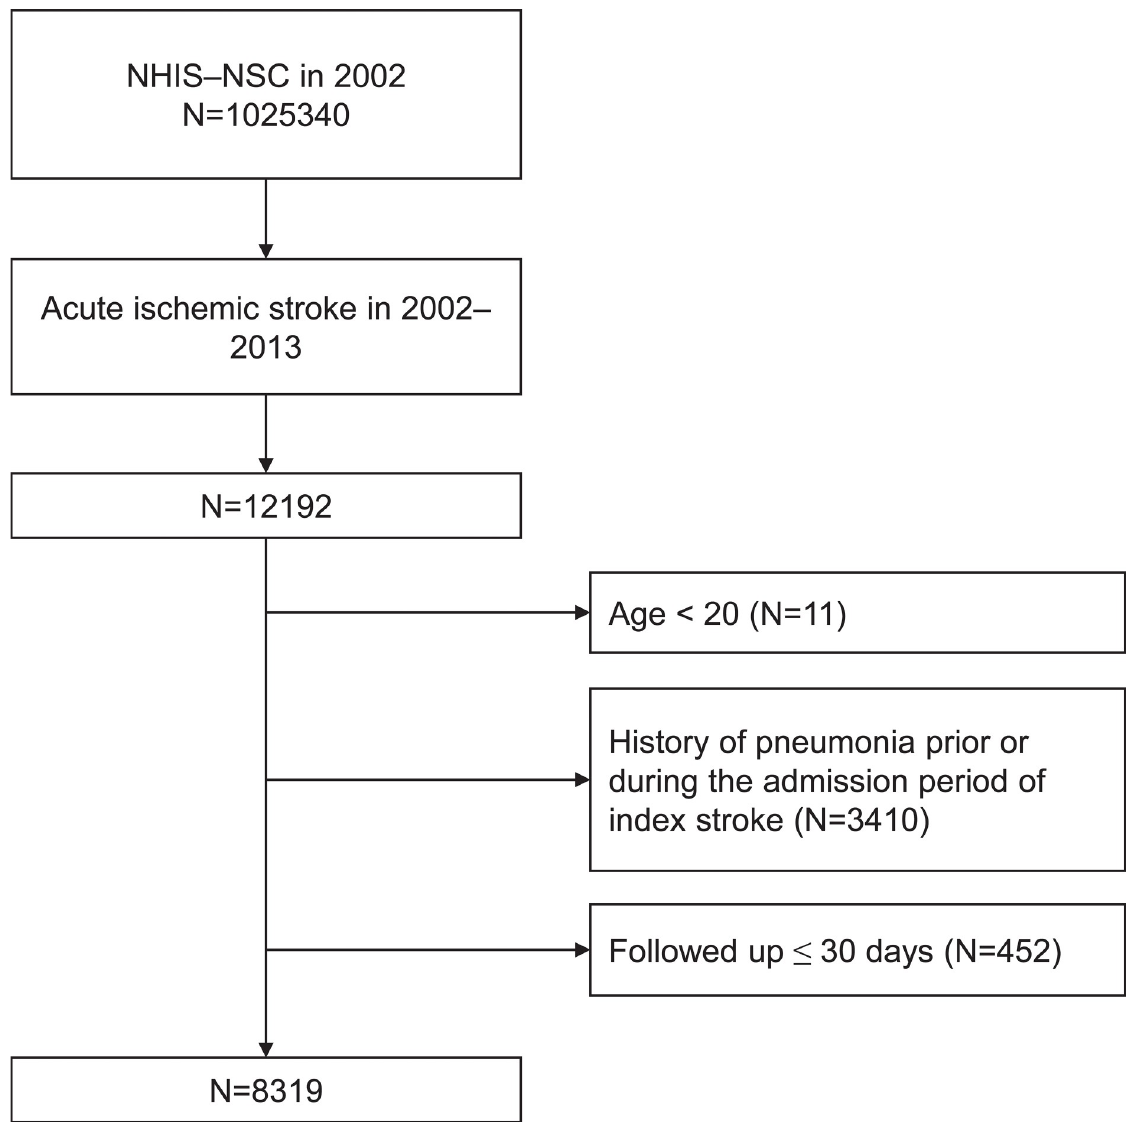
Fig 1. Flowchart of included